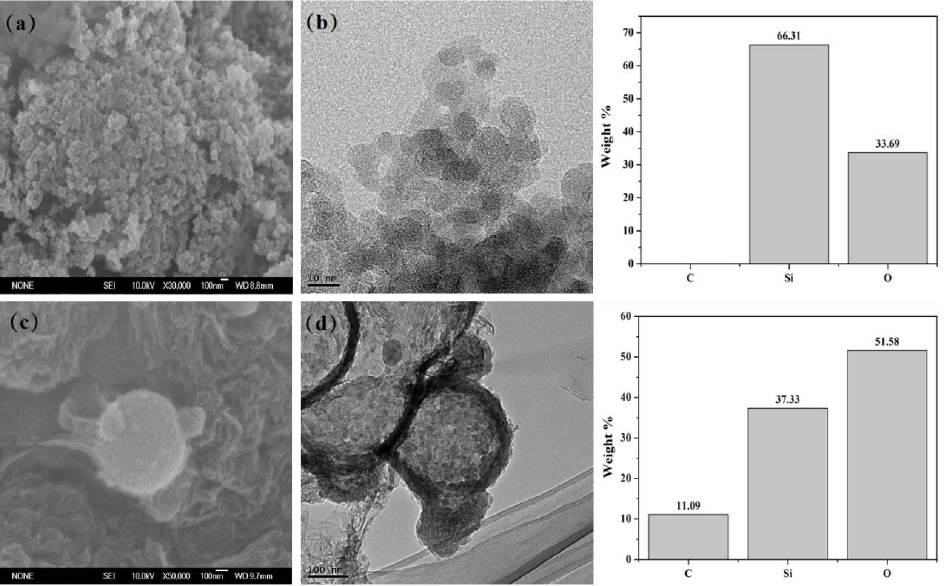
Figure 1. ( a ) SEM image of SiO 2 and ( b ) TEM image of SiO 2 . ( c ) SEM image of the rGO / SiO 2 nanocomposite and ( d ) TEM image of the rGO / SiO 2 nanocomposite.